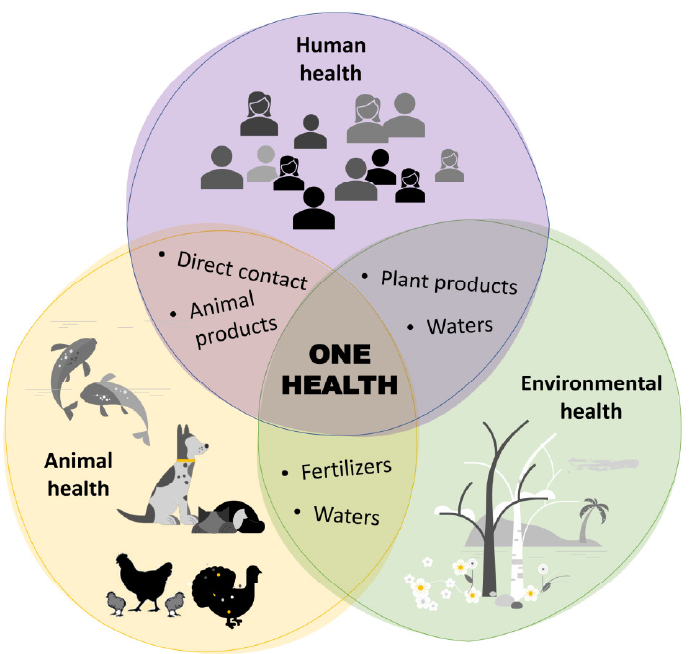
Figure 1. Interconnection between humans, animals, and the environment within the One Health concept.